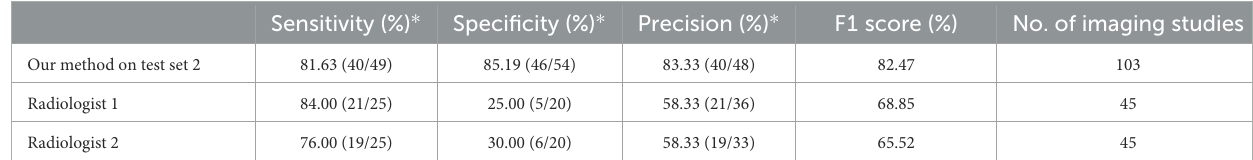
TABLE 3 Comparison of performance between our model and radiology readers in prediction of EMCI and LMCI.